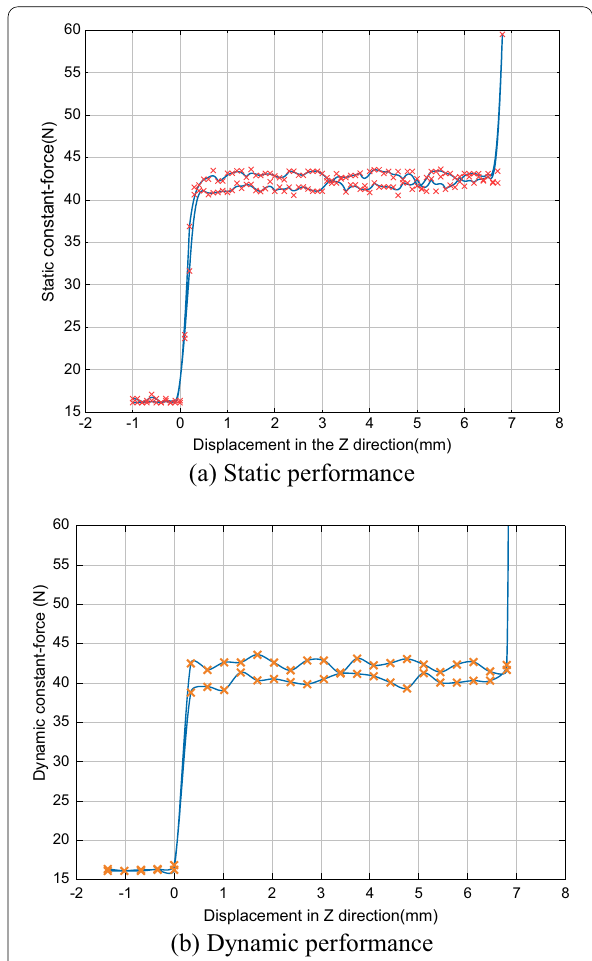
Figure 8 Experimental results of the constant force